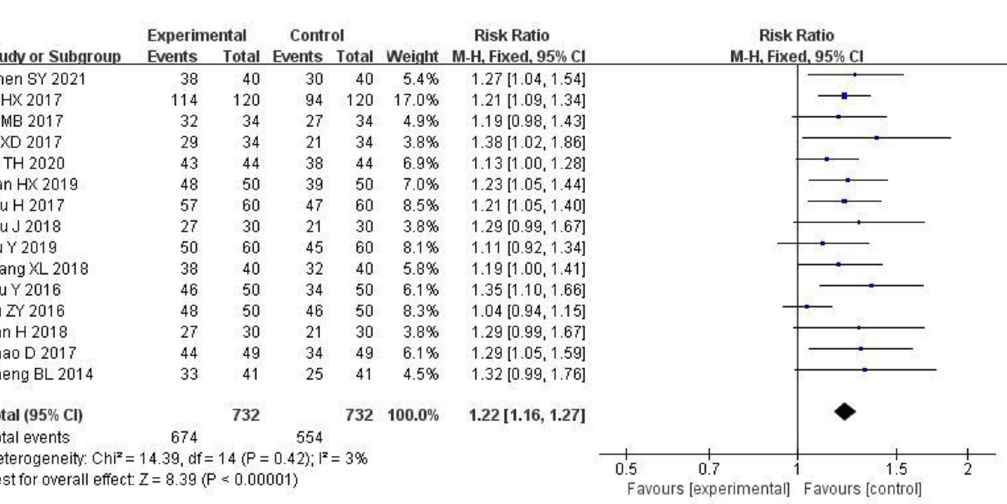
Fig 3. Forest plot of effects of Shenyankangfu tablets and Losartan potassium in the treatment of chronic glomerulonephritis on effective rate.